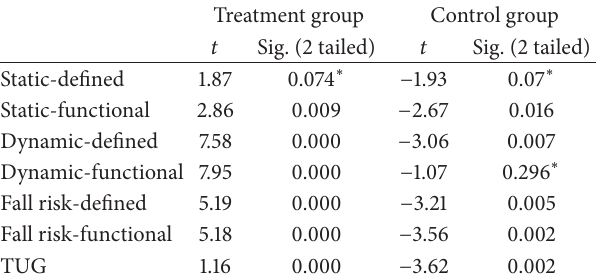
Table 4: Paired sample 𝑡